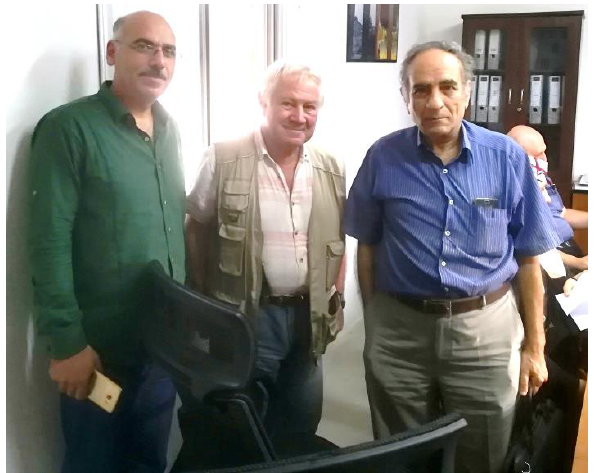
Figure 16: Myself with prof. Hassan Jabreeni, photogrammetrist (left) and prof. Ammar Kaadan, structural eng.